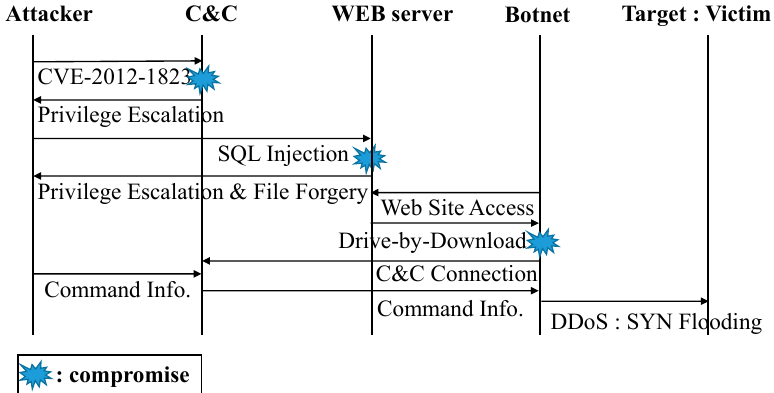
Figure 10. SYN flooding scenario.